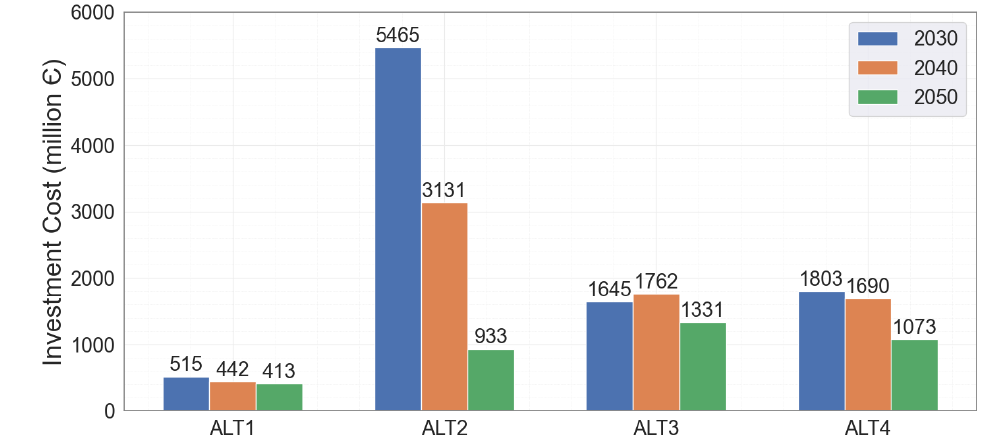
Figure 17. Comparison of the evolution of investment costs between alternatives for the residential sector (million €